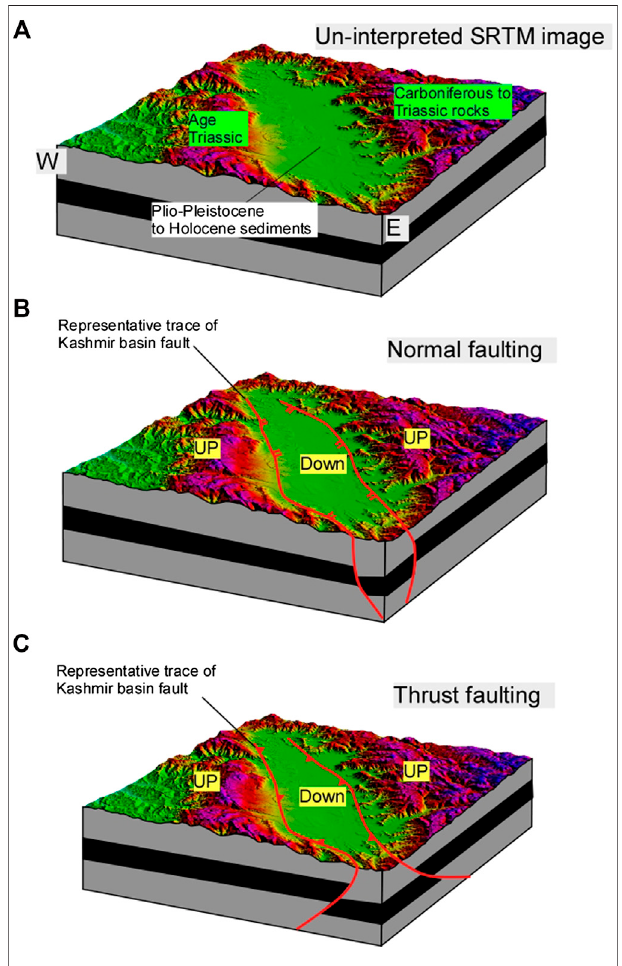
FIGURE 10 | The un-interpreted shutter radar topography shows the extent of Kashmir basin (A) , and the present topography where the basin is bounded by mountains on all sides. Broadly, the rift tectonic model suggests that such a topography requires at least two major normal faults (B) , however, reverse faults can also form a similar topography (C)